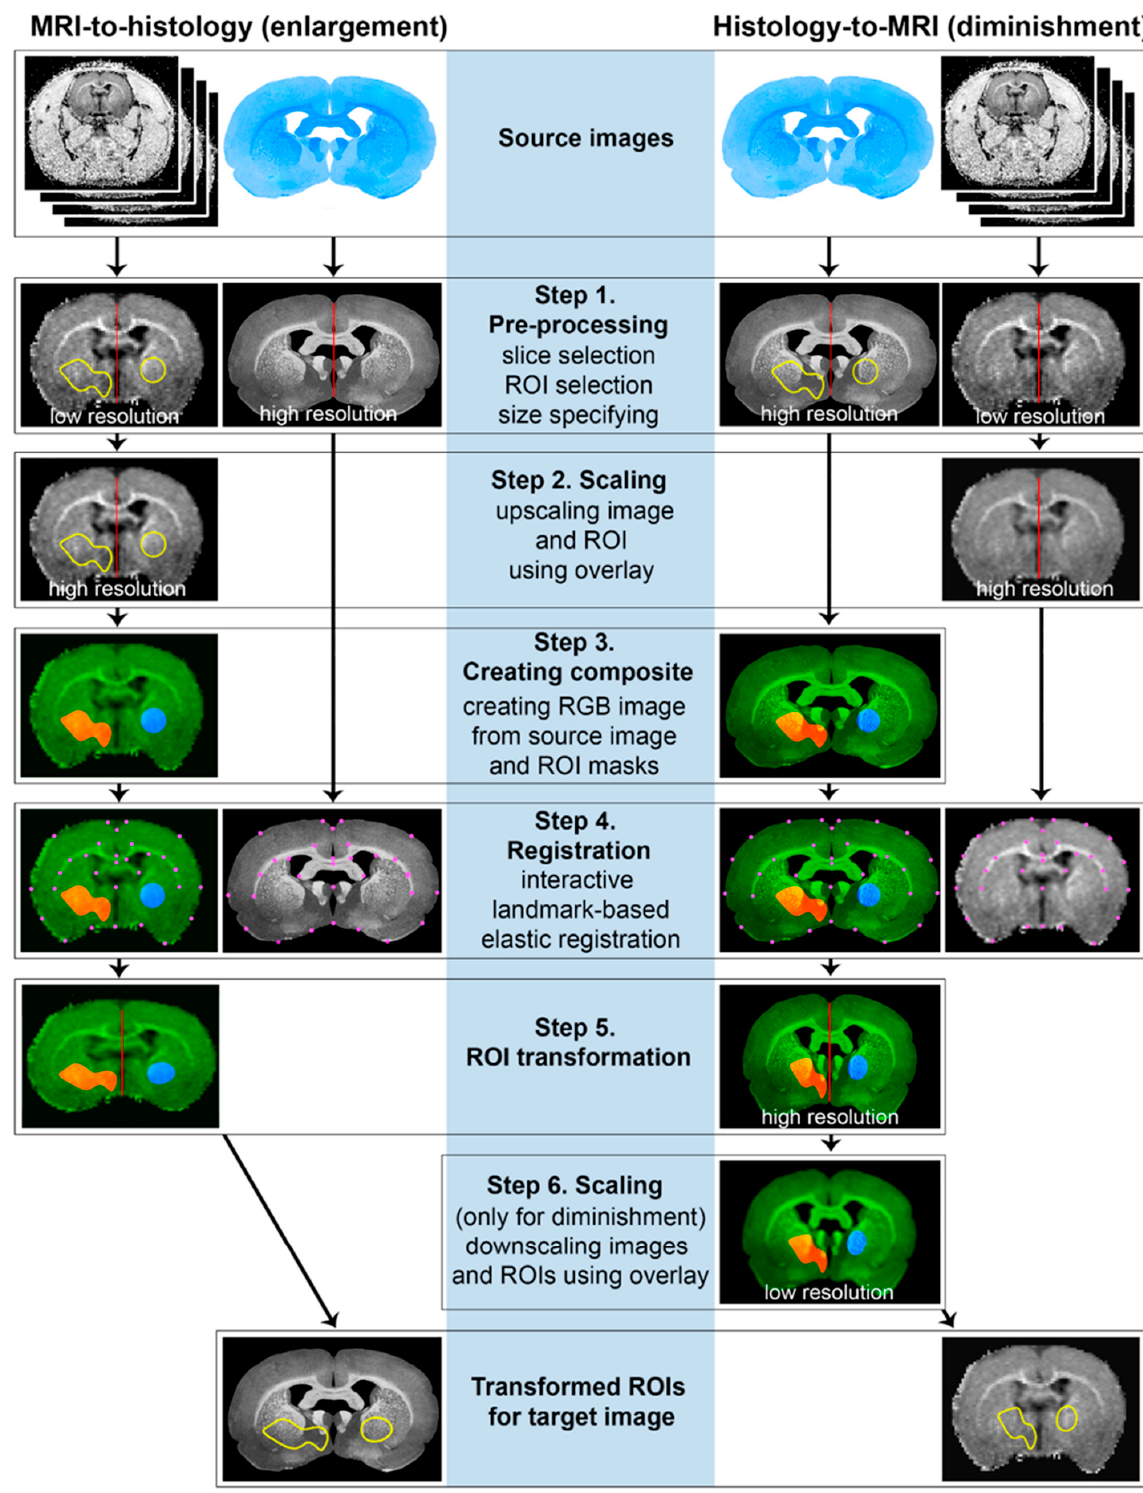
Figure 1. Step-by-step schematic diagram of the ROIT method algorithm for “MRI-to-histology” and “Histology-to-MRI” transformations. Step 1.